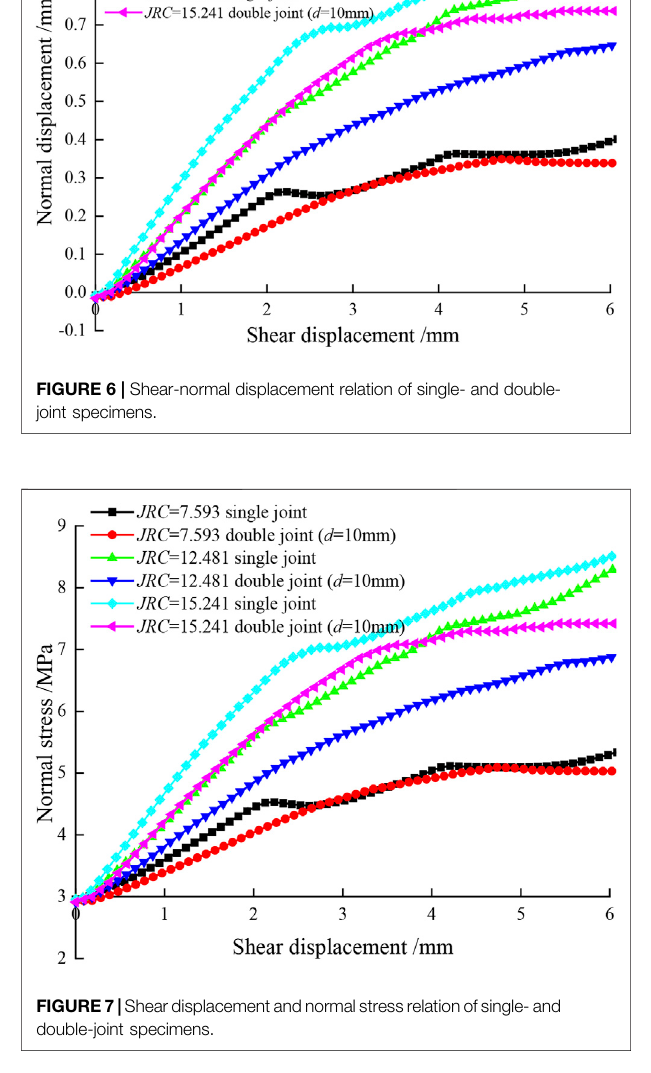
FIGURE 9 | Shear displacement-stress relation of J3 with different